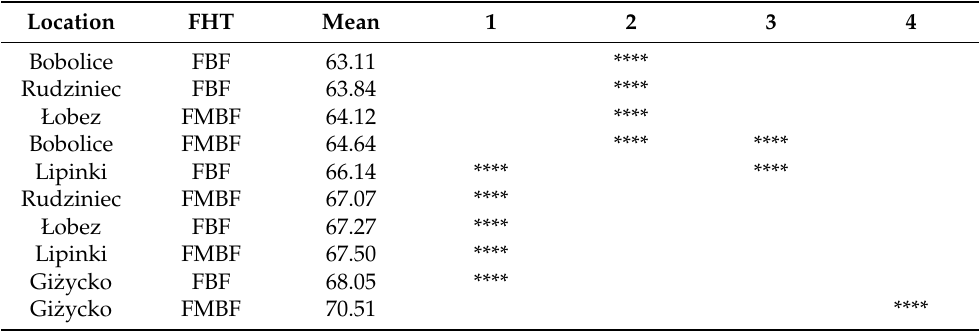
Table 6. Homogeneous groups in terms of mean wood hardness values for locations and habitat types (HSD Tukey’s range test).